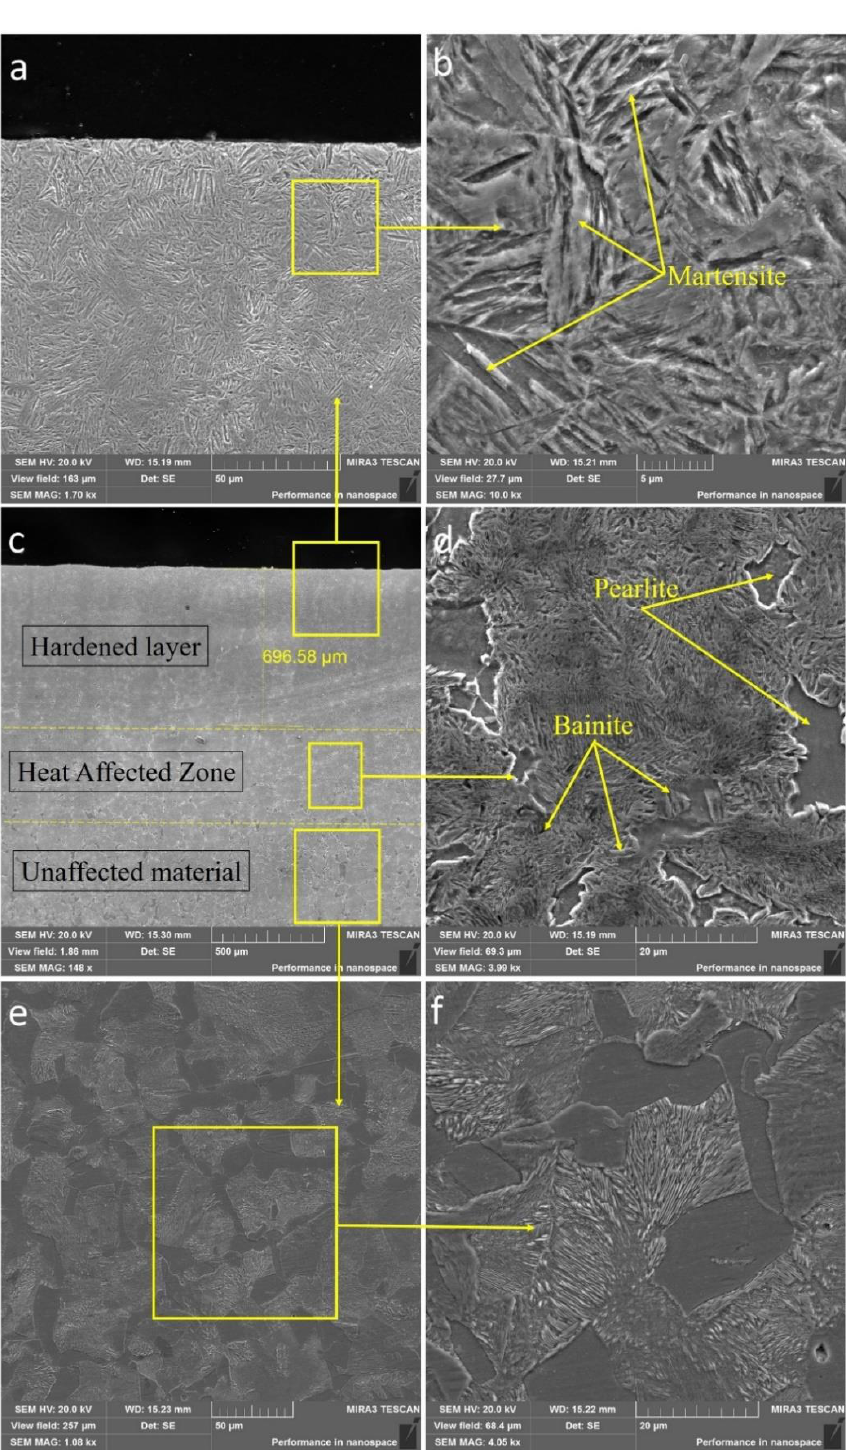
Figure 5. SEM images of the cross-section of sample No. 2. ( a ) hardened layer at ×1700 and ( b ) ×10,000, ( c ) micrography at ×150, ( d ) heat affected zone at ×4000, ( e ) unaffected material at ×1000 and ( f ) ×4000.